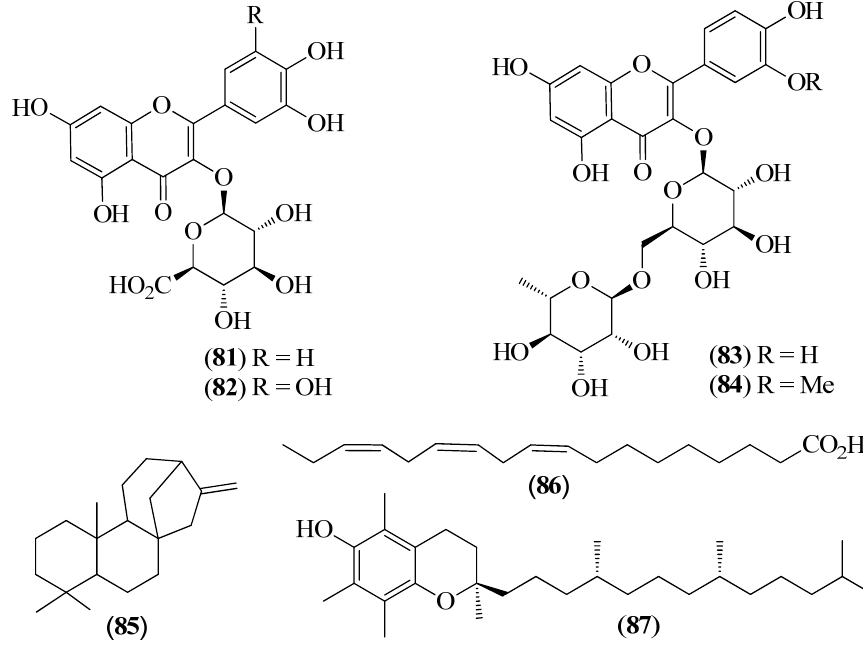
Figure 12. Structures of compounds 81 – 84 from Oreocallis grandiflora and 85 – 87 from Roupala montana .